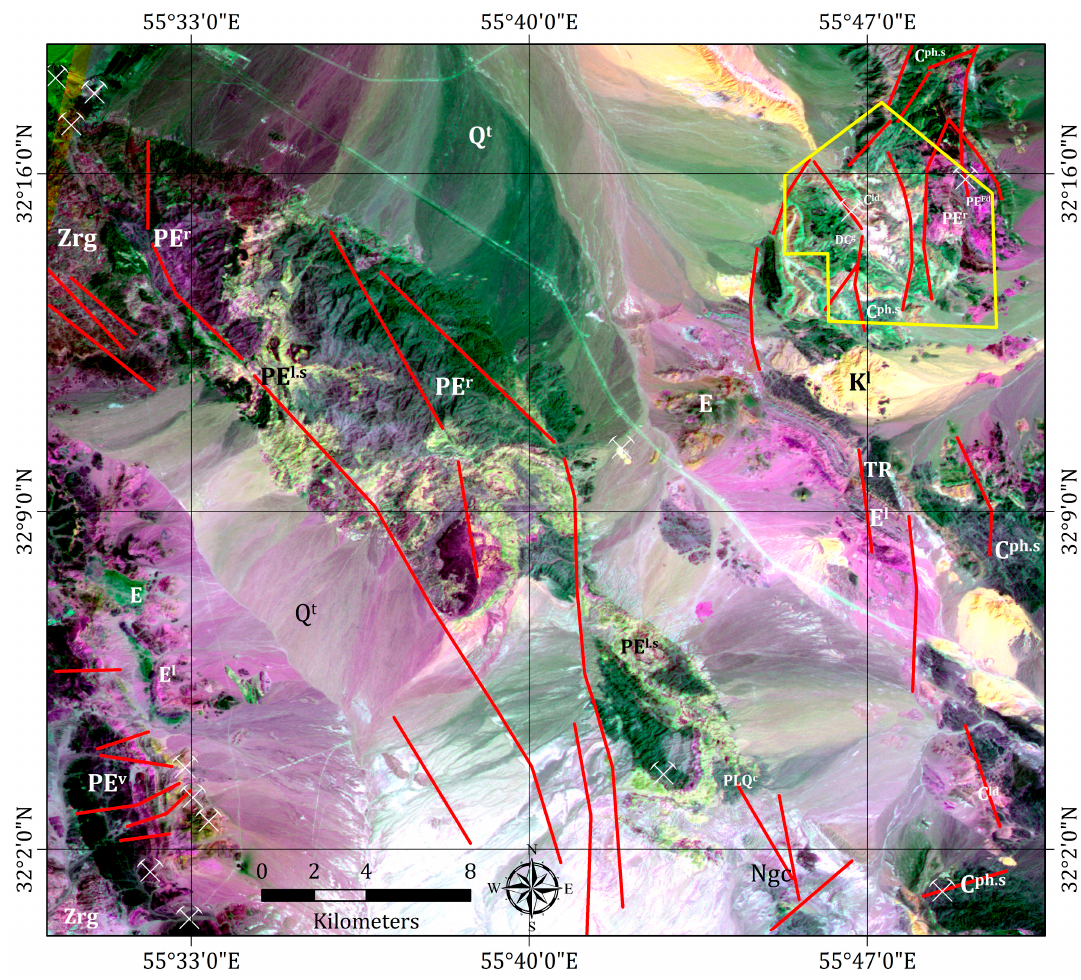
Figure 5. Regional view of lithological units and alteration zones in the study region. RGB false color composite of bands 6, 2 and 8 for ASTER. Yellow polygon demarcates WV-3 imagery.